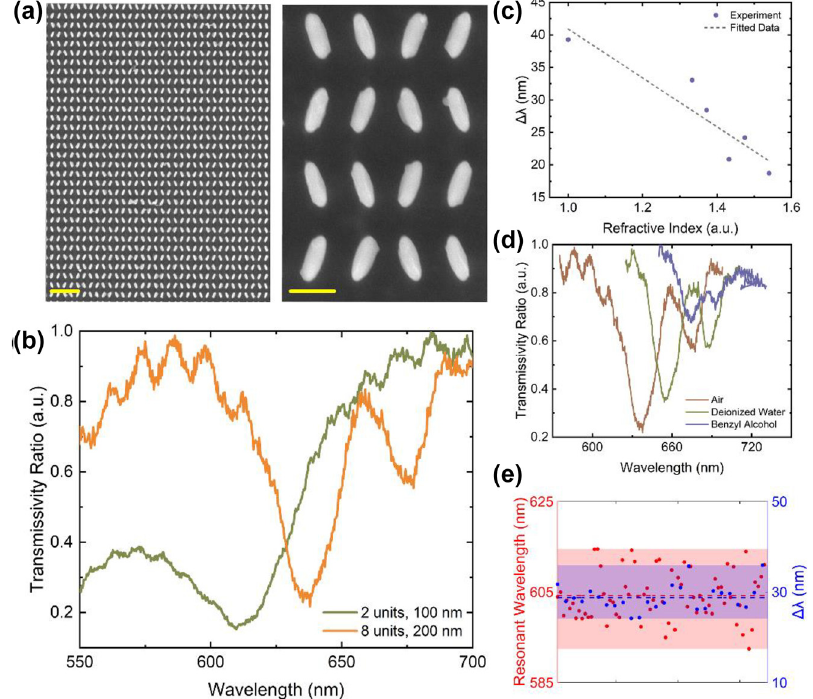
Figure 5: Experimental dual-resonance sensing performance of the designed metasurface. (a) SEM images of the top view of the fabricated metasurface, which contains eight 200-nm-height nanopillars in one period. The right image shows a magnified view of two periods. (b) Normalized transmission spectra of two fabricated metasurfaces, containing two 100-nm-height nanopillars and eight 200-nm-height nanopillars each period, respectively. (c) Variations of resonance peak interval Δ 𝜆 in six media and the fitted results. (d) Three typical transmission spectra conducted in air, deionized water and benzyl alcohol, respectively. (e) Comparison of the fluctuation ranges between the single-resonance sensing and dual-resonance sensing, which both contain eight nanopillars in one period but only differed in terms of nanopillar